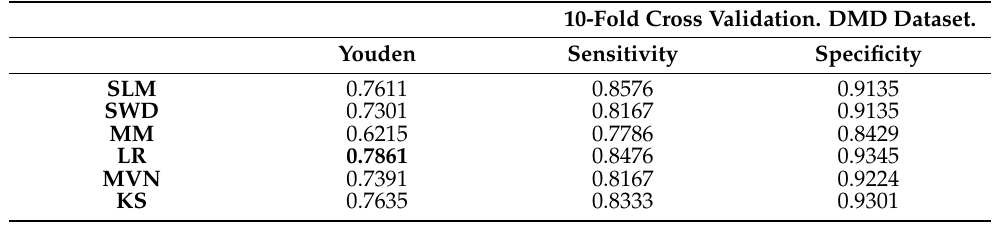
10-Fold Cross Validation. DMD